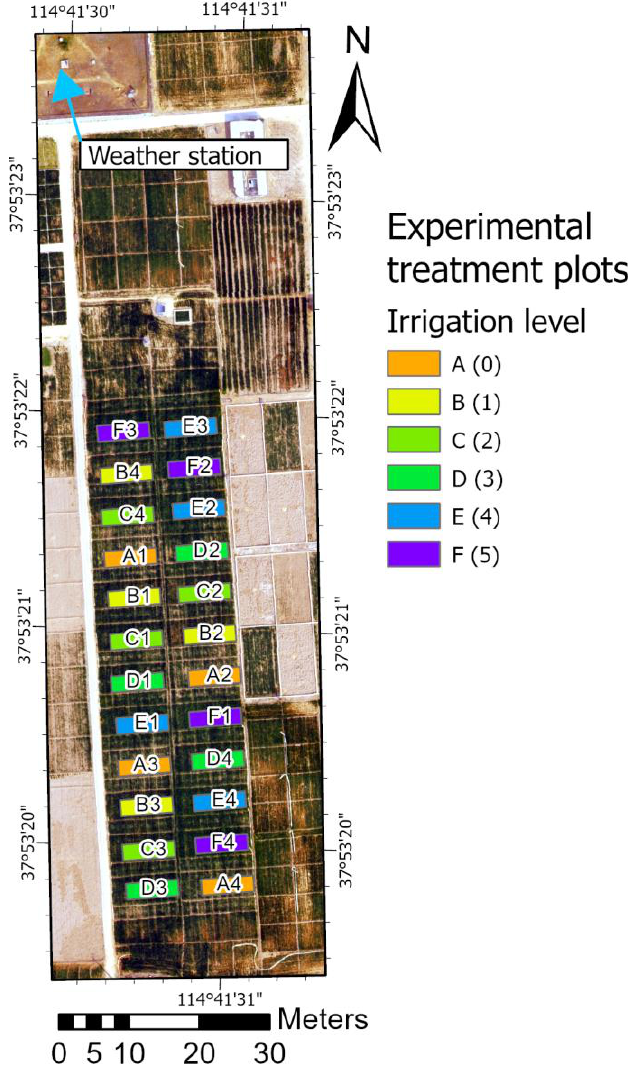
Figure 1. Outline of the experimental field setup at Luancheng Agro-Ecological Experimental Station with the location of the weather station and layout of the experimental treatment plots (codes are shown in Table 1).